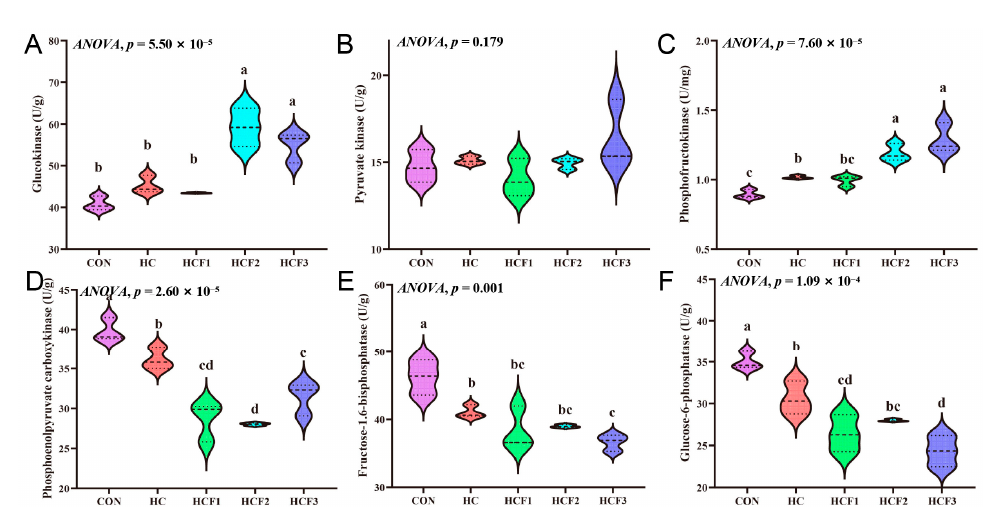
Figure 1. Influences of dietary mulberry leaf flavonoids on carbohydrate metabolism enzymes activities in liver in rice field eel fed on a high-carbohydrate diet. ( A ) Glucokinase, GK; ( B ) Pyruvate kinase, PK; ( C ) Phosphofructokinase, PFK; ( D ) Phoenolpyruvate carboxykinase, PEPCK; ( E ) Fructose-1.6-bisphosphatase, FBPase; ( F ) Glucose-6-phosphatase, G-6-Pase. Different letters show a significant difference ( p < 0.05).